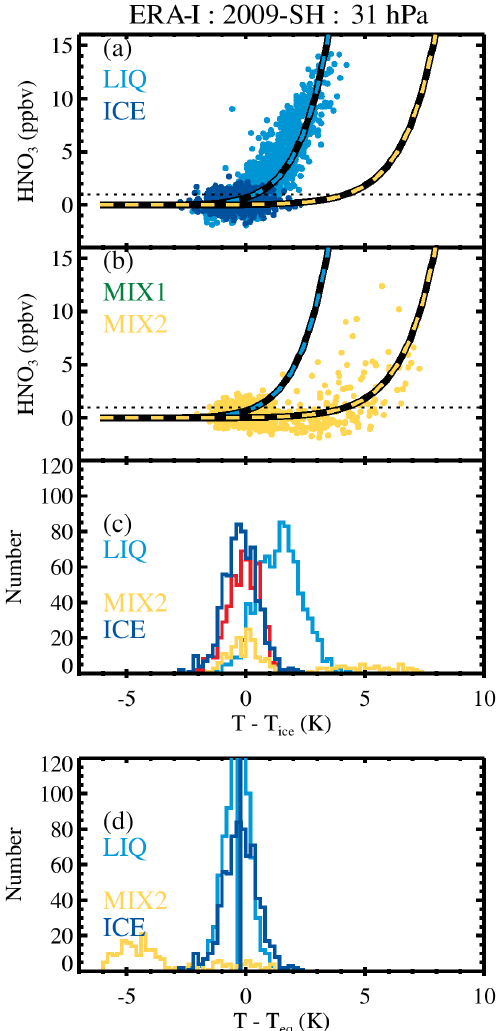
Figure 13. Composite statistics for d140–d230 (the bulk of the PSC formation period) of a representative year (2009) of the MLS gas- phase HNO 3 variation with ERA-I temperature corresponding to CALIOP PSC classifications at 32hPa, with the added constraint that at least 75% of the MLS FOV is filled with the same classi- fication. (a) Scatterplot of HNO 3 vs. temperature deviation from the frost point ( T − T ice ) for PSCs classified as LIQ (cyan) and ICE (blue). (b) The same as for panel (a) but for MIX2 PSCs (yel- low; because of non-equilibrium effects, which cause larger tem- perature scatter, MIX2 PSCs are not used in this analysis, but this panel is shown to indicate the good discrimination between the solid and liquid uptake curve branches). Equilibrium STS (black/cyan dashed) and NAT (black/yellow dashed) curves show the theoret- ical uptake of HNO 3 . (c) Temperature histograms for HNO 3 mix- ing ratio > 1ppbv for LIQ PSC type; data in the ICE classification are not subject to this constraint. The red histogram indicates the distribution of LIQ PSCs that have HNO 3 below the 1ppbv thresh- old. (d) Temperatures transformed according to the STS equilibrium curve for the LIQ classification and NAT equilibrium curve for the MIX2 classification; the ICE classification remains the same as in panel (c) for